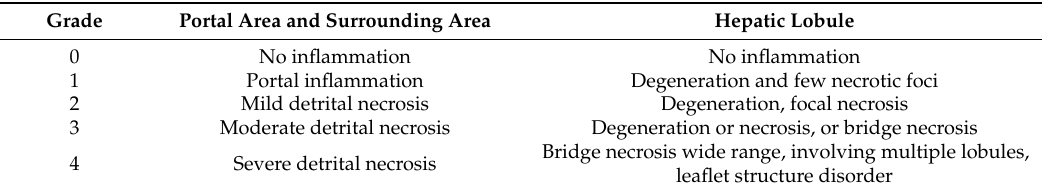
Table 1. Pathological grading of liver injury.